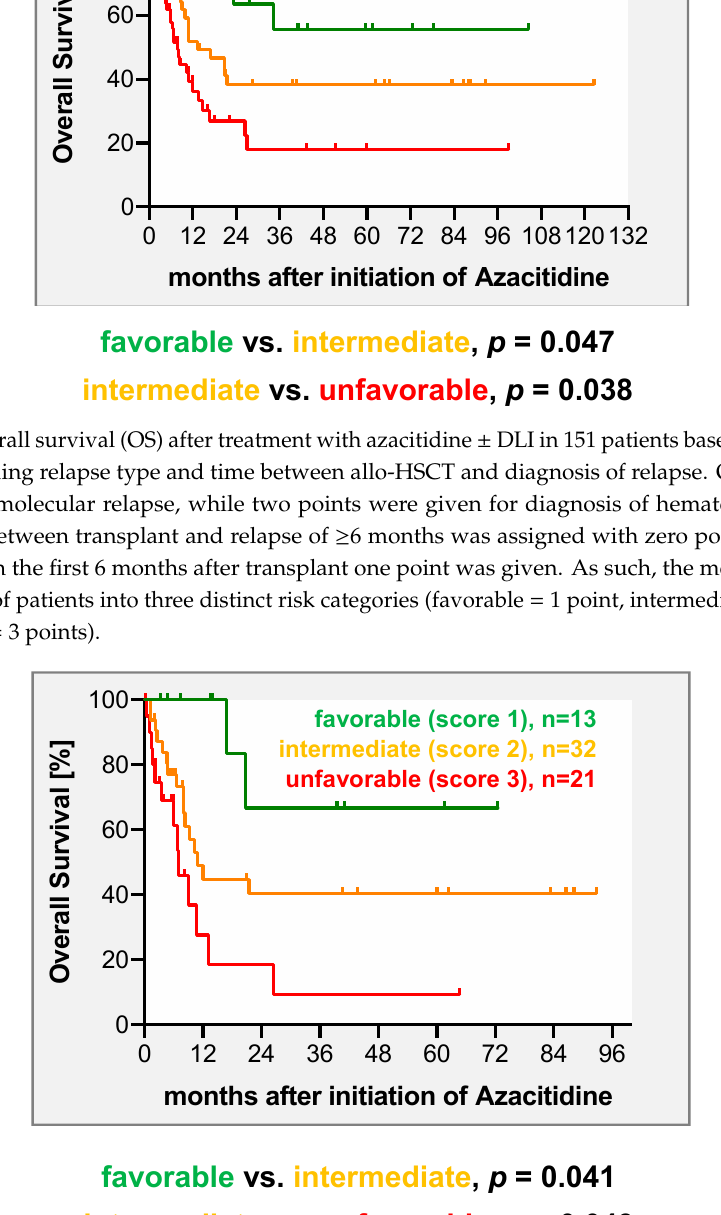
Table 5. Two-year overall survival and response rates of 66 patients with MDS and sAML with 20– 29% BM blasts treated with azacitidine ± DLI for relapse after allo-HSCT according to the proposed scoring system.